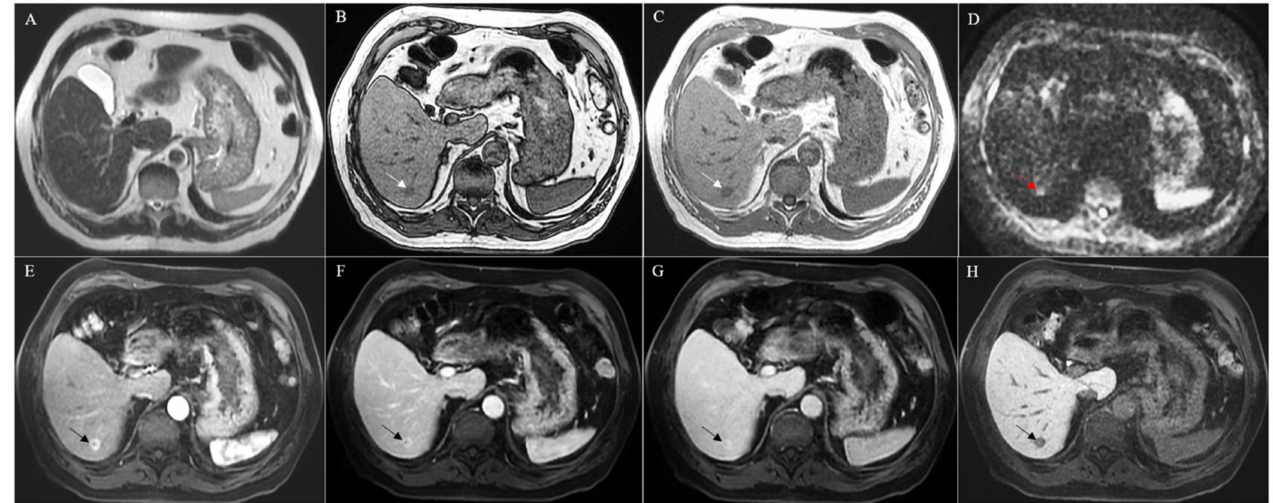
Figure 2. MRI with Gd-EOB-DTPA of a histologically confirmed combined hepatocellular cholangiocarcinoma located in the segment VI of the liver (arrow). The lesion presented without strong hyperintensity at the T2-weighted image ( A ) but showed hypointensity both in in- and out-of-phase T1-weighted images ( B , C ) and strong hyperintensity in the diffusion-weighted image ( D ). A strong hyperenhancement was evident during the arterial phase ( E ), followed by a persistent enhancement during the portal and late venous phases ( F , G ). In the hepatobiliary phase, the lesion appeared hypointense ( H ).